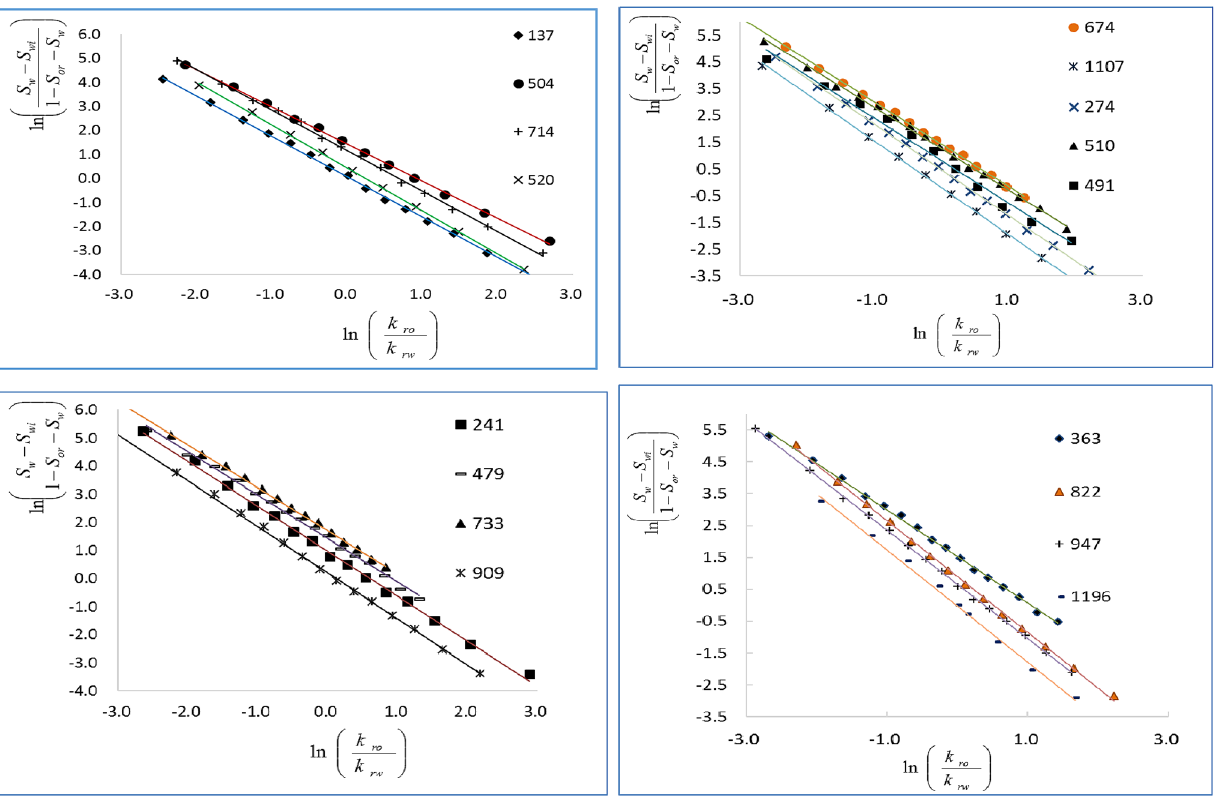
Fig. 1 Cross-plots of different samples between ln . (Numbers in the legend are the sample numbers. The lines in the sub-figures are linear regression trend lines)